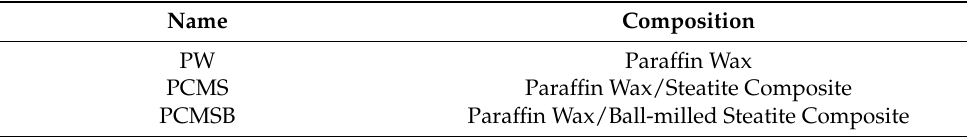
Table 2. Energy storage material with different compositions.